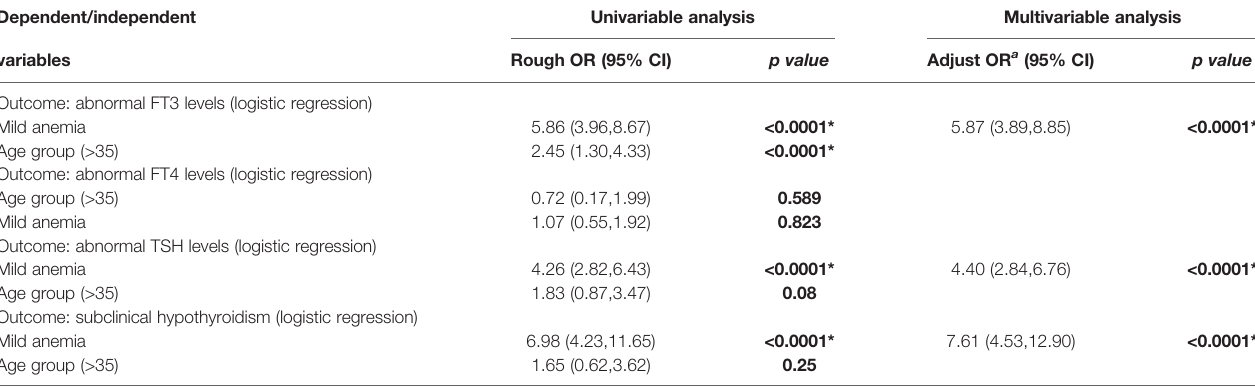
TABLE 5 | Results from the univariable and multivariable logistic regression analysis.